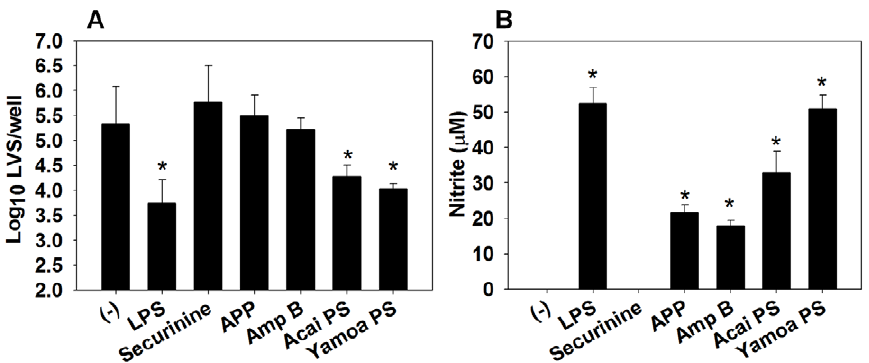
Figure 1. Natural agonists restrict replication of F.tularensis LVS in RAW264.7 macrophages. RAW264.7 macrophages (10 6 /well, 3 wells/ treatment) were stimulated overnight ( , 14 h) with 50 ng/ml LPS, 40 m M securinine, 40 m g/ml APP, 500 ng/ml amphotericin B, 10 m g/ml Acai PS, or 10 m g/ml Yamoa PS prior to infection with F. tularensis LVS (MOI , 300). After 20 h of infection, A) macrophages were lysed, and supernatants were diluted for CFU enumeration, and B) nitrite levels in the supernatants were determined. Error bars represent SD, * P , 0.05, as compared to untreated cells. Data are representative of two independent experiments.